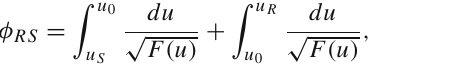
Fig. 2 Schematic figure for the regions D R and D S (adopted from Ref.